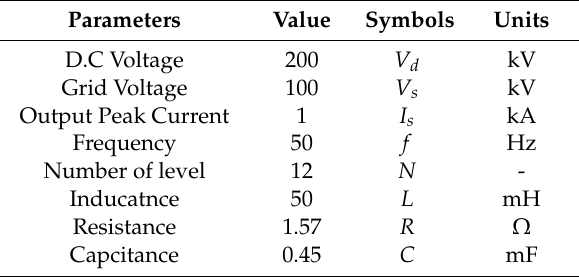
Table A1. Converter